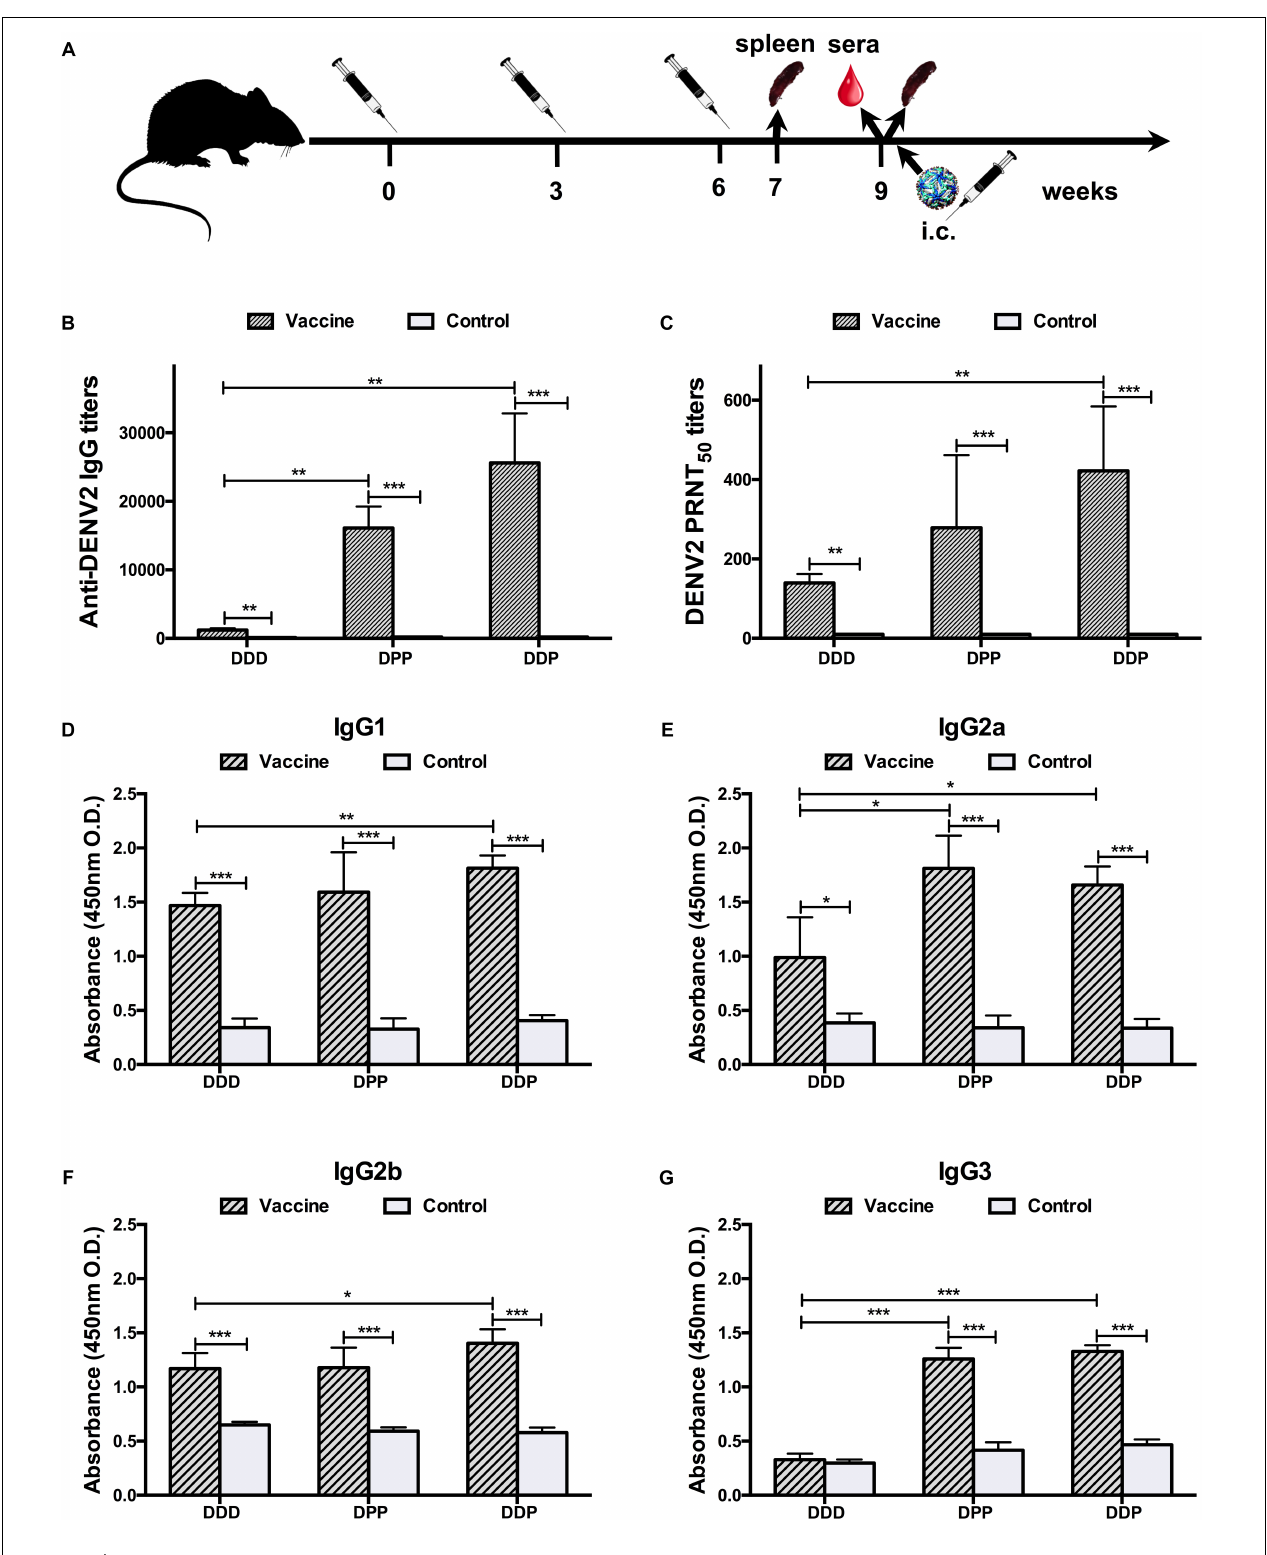
FIGURE 1 | Immunization schedule and humoral immune response to DENV2 induced by different immunization regimens. (A) Immunization, sampling, and challenge timeline. (B) Anti-DENV2 IgG antibody titers. (C) Anti-DENV2 nAb titers in serum samples ( n = 8) and data represent the GMT + SD. (D–G) Distribution of serum DENV2-specific IgG subclass responses, (D) IgG1; (E) IgG2a; (F) IgG2b; and (G) IgG3. The levels of IgG subclass were expressed as 450 nm OD. Data were expressed as means + SD ( n = 8). ∗ P < 0.05, ∗∗ P < 0.01, ∗∗∗ P < 0.001.